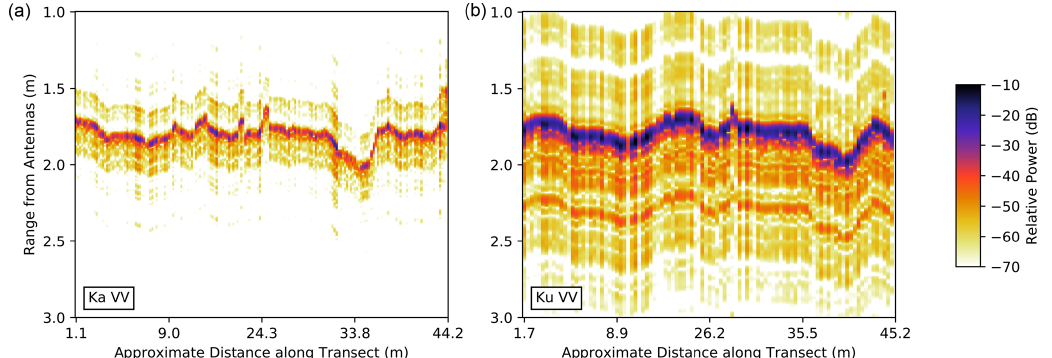
Figure 10. Ka- (a) and Ku- (b) band VV-polarized signal power as a function of distance along the refrozen lead. Data acquired on 24 January 2020 at